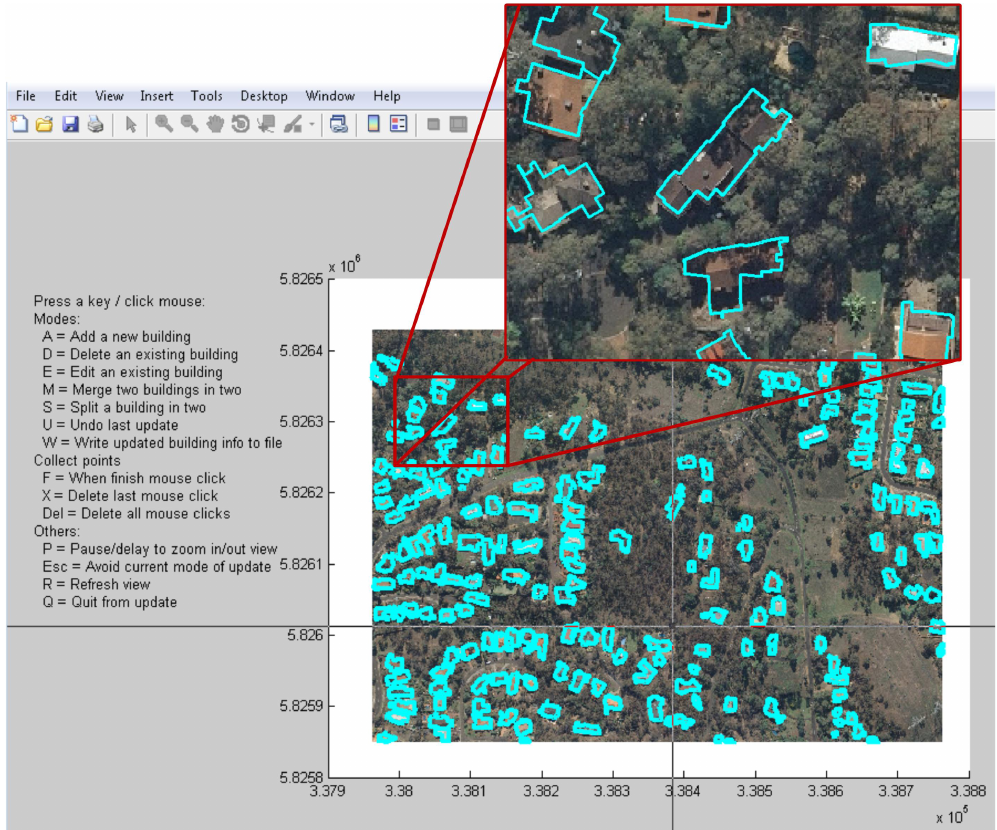
Figure 3. A simple GUI for the generation of the building map